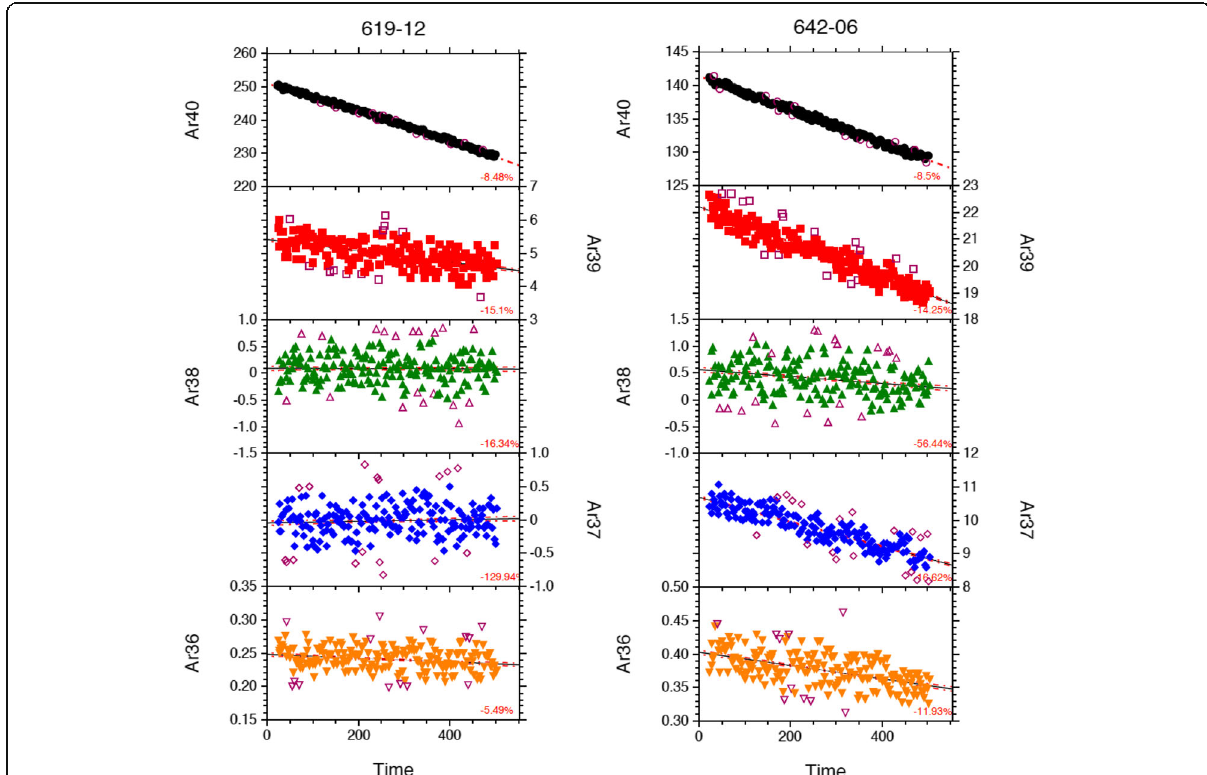
Fig. 7 Examples showing the elimination of the peak suppression effect: (left) alunite, (right) basaltic rock. Note that the intensities of the 40 Ar and 36 Ar ion beams are decreasing during the measurement